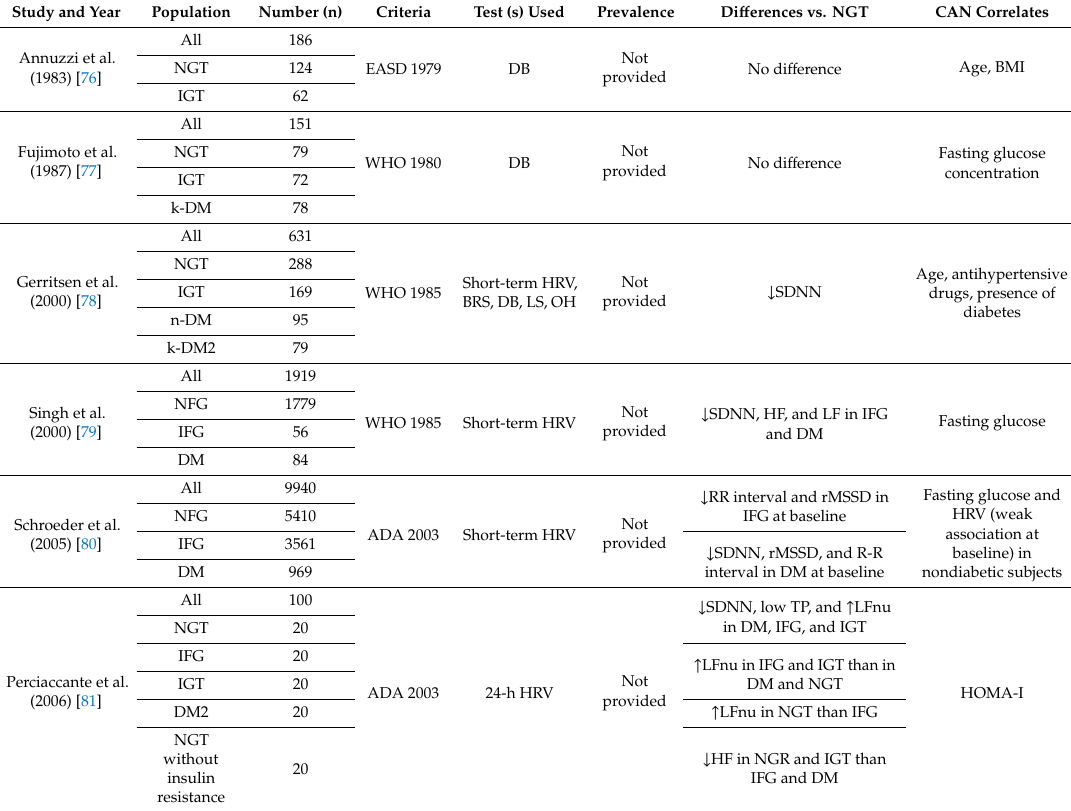
Table3. Studiesevaluatingthepresenceofcardiovascularautonomicneuropathy(CAN)inpre-diabetes. Study and